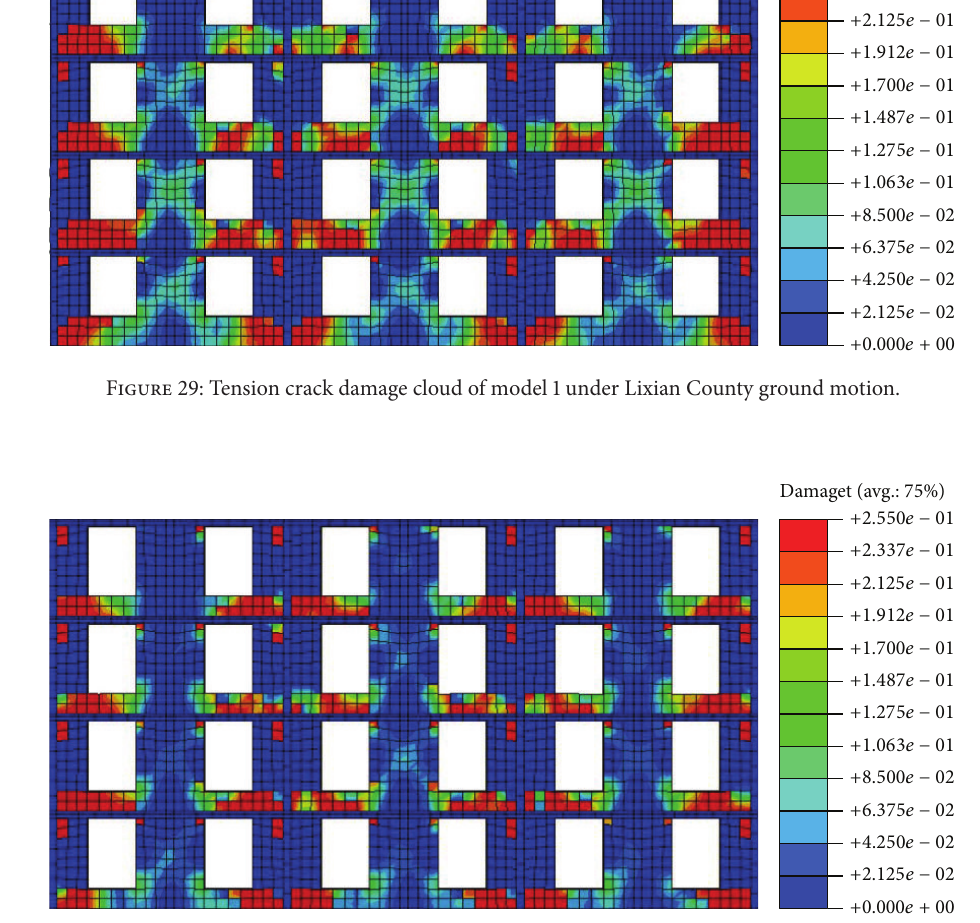
Figure 30: Tension crack damage cloud of model 5 under Lixian County ground motion.